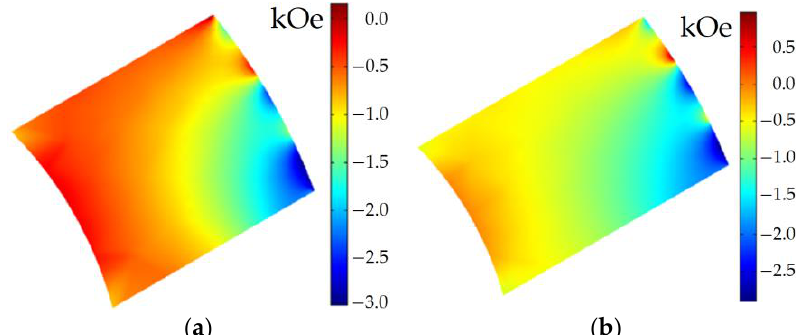
Figure 14. Field of the demagnetizing force (kOe) acting on the permanent magnet of the rotor at the maximum torque (at 750 rpm): ( a ) Before optimization, minimum value is −3.0 kOe; ( b ) After optimization, minimum value is −2.9 kOe.